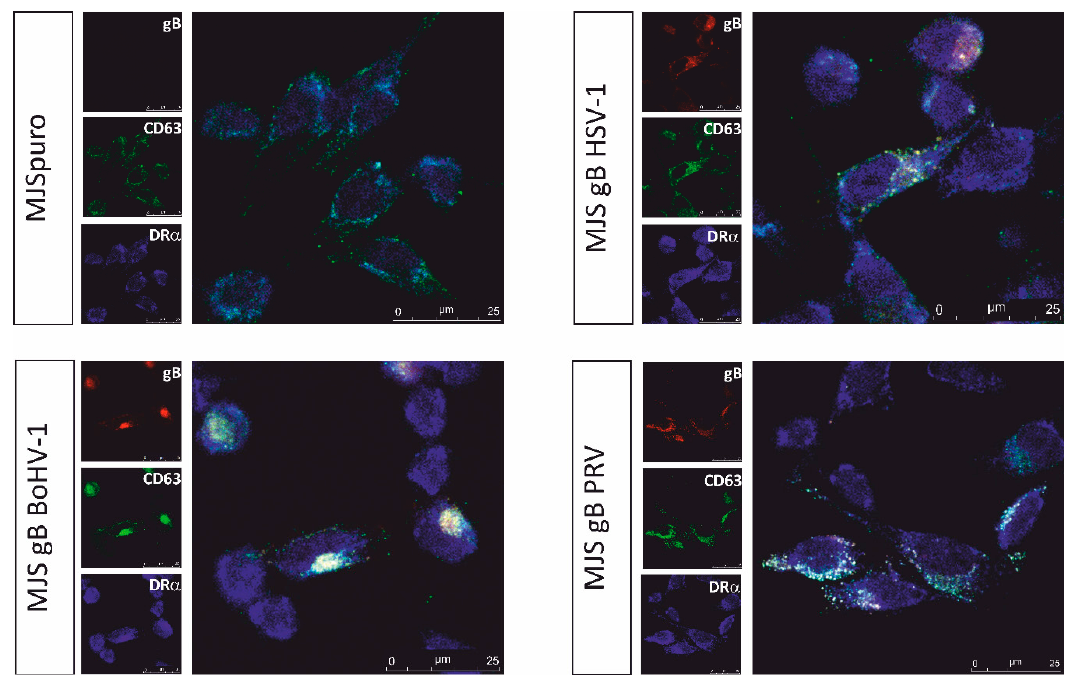
Figure 3. Intersection of gB, late endosome/exosome marker CD63 and major histocompatibility (MHC) class II (DR α ) trafficking. Subcellular localization was analyzed by immunofluorescence-confocal laser scanning microscopy. gB was stained with specific mAb and Alexa 546-conjugated anti-mouse IgG ( red ), CD63 with goat antibodies and Alexa 488-conjugated anti-goat IgG ( green ) and the DR α subunit of MHC II with rabbit antibodies and Alexa 633-conjugated anti-rabbit IgG ( blue ). Table 1. Analysis of gB/CD63/MHC II (DR α ) co-localization by Pearson’s correlation coefficient measurement using the Leica Appilication Suite X. The data correspond to mean ± SD of at least five independent pictures; not determined (nd).